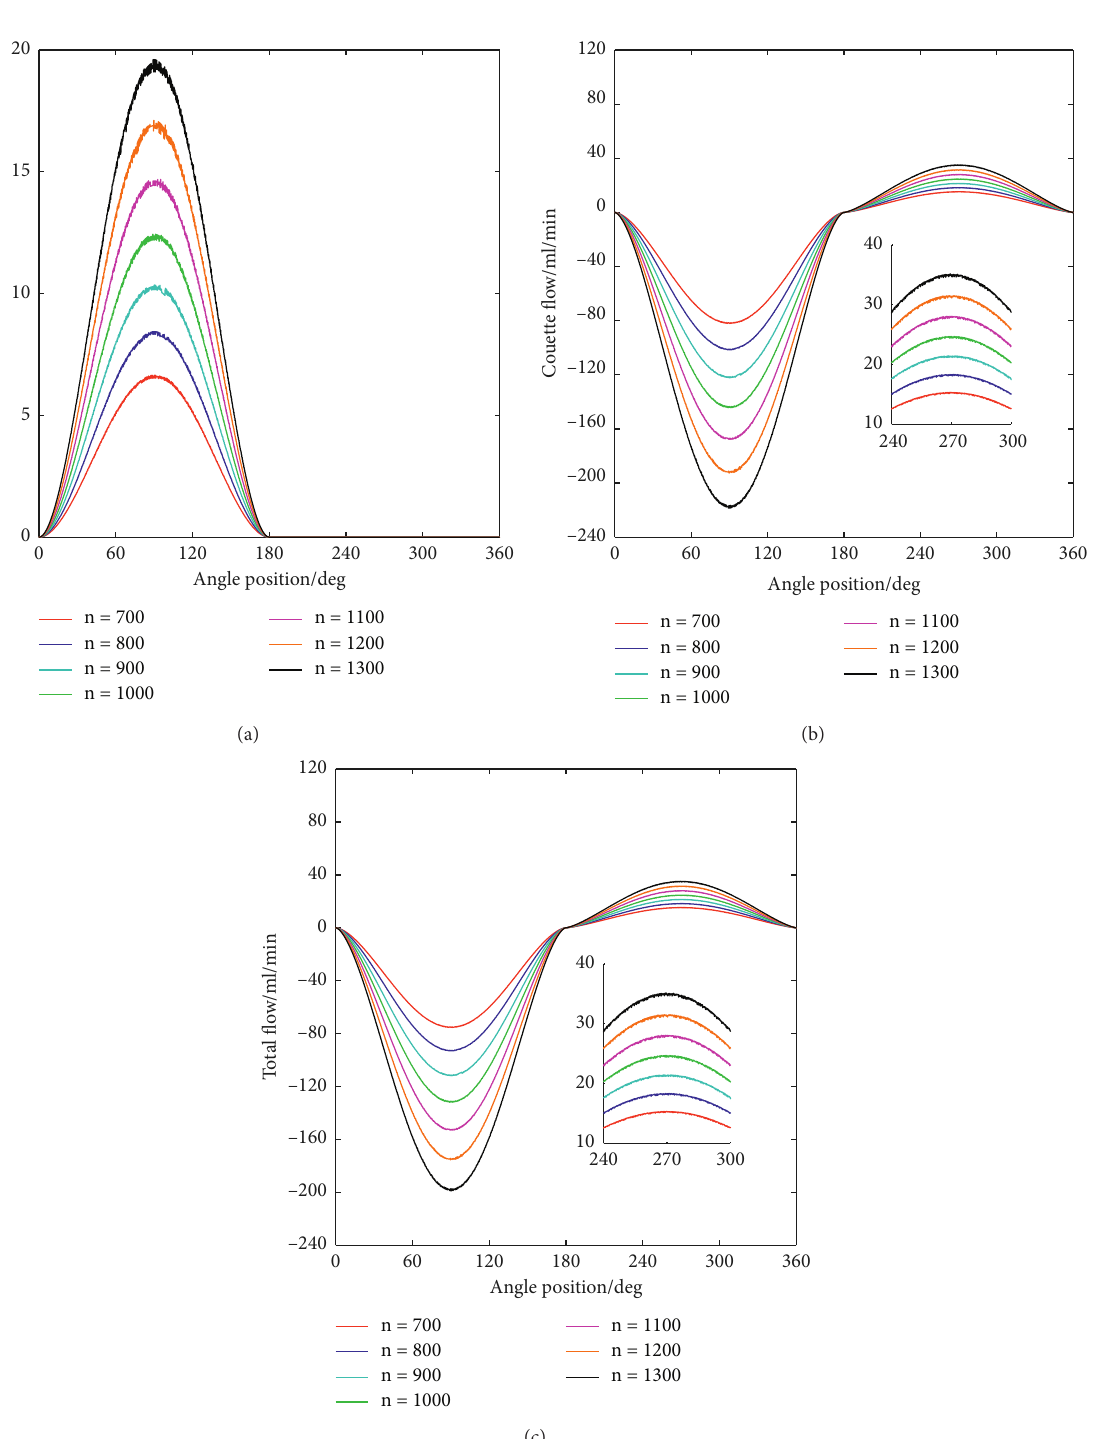
Figure 12: The leakage of PRCB per piston at different rotational speeds. (a) The Poiseuille flow; (b) the Couette flow; (c) the total flow